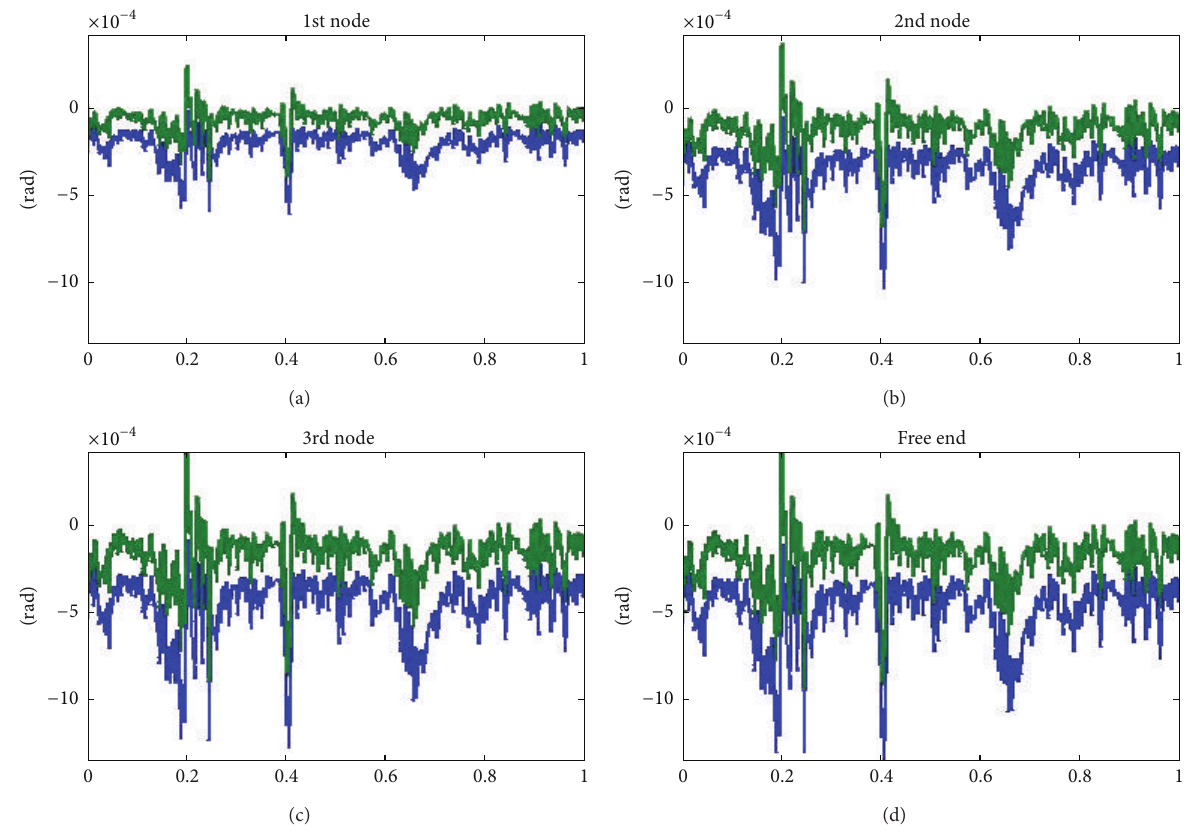
Figure 5: Angle of rotation at all beam nodal points, with and without LQR control.